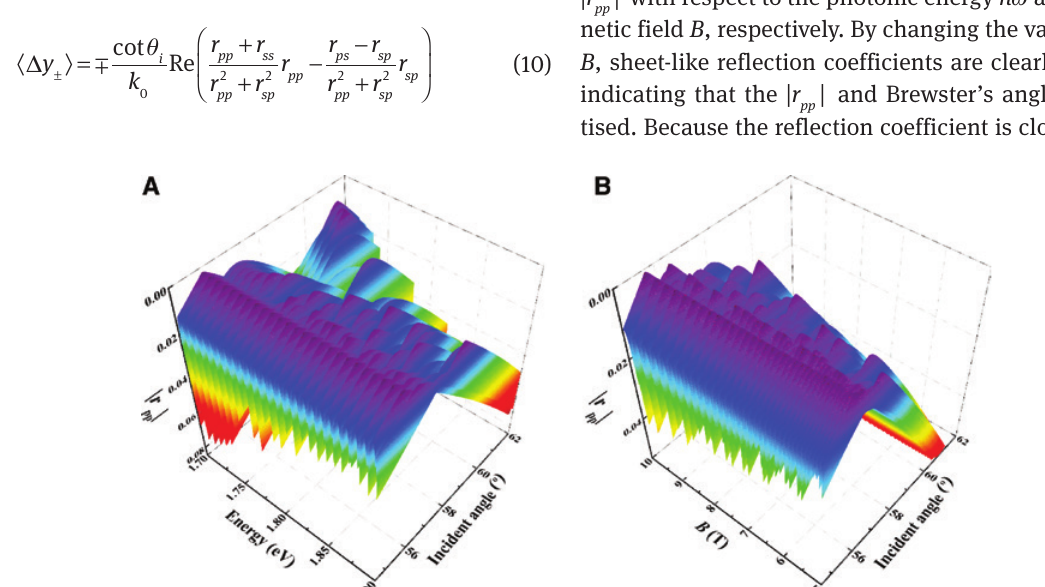
Figure 2: The magnetic field B in (A) and the photonic energy in (B) are set as 10 T and 1.8 eV, respectively. Variations of the Fresnel reflection coefficient | r